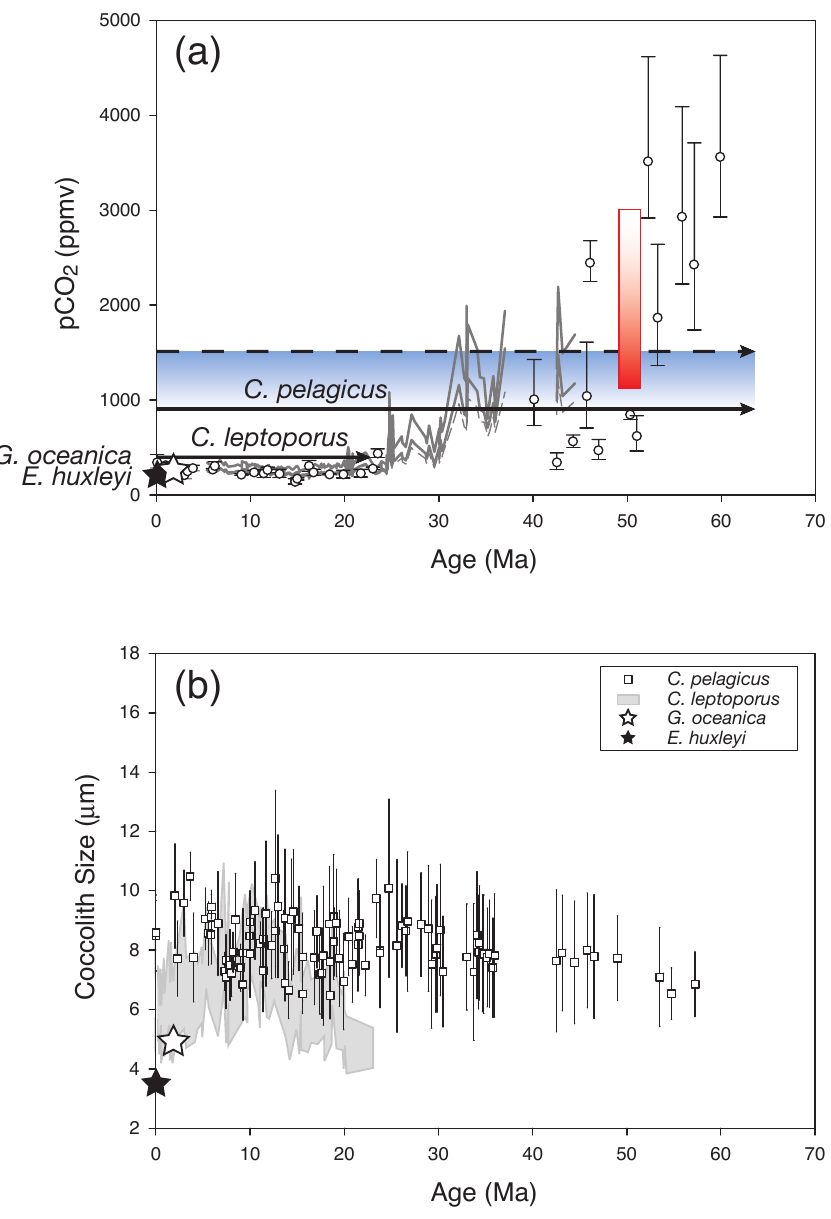
Fig. 1. (a) At face value, the levels of pCO 2 tolerated by different coccolithophore species for calcification in culture experiments (Riebesell et al., 2000; Langer et al., 2006) coincide with levels of pCO 2 from marine proxy reconstructions, based on alkenones (solid and dashed lines; Pagani et al., 2005) and boron isotopes in planktic foraminifera (open circles; Pearson and Palmer, 2000), at the time of emergence of each respective morphospecies; marked by a star for E. huxleyi (291–268ka; closed star) and G. oceanica (1.7Ma; open star), and solid arrows for C. leptoporus (23Ma) and C. pelagicus ( ∼ 63Ma). The upper pCO 2 tolerance range for C. pelagicus is indicated by the blue box with a solid arrow at the maximum pCO 2 , thus far tested, at which its calcification remains unaffected (Langer et al., 2006), and dashed arrow showing the potential for this species, with further experiments, to determine the Palaeogene maximum pCO 2 . The red box depicts the pCO 2 range in which the sodium carbonate nahcolite precipitates (Lowenstein and Demicco, 2006), fixing minimum early Eocene pCO 2 at 1125 ppmV. (b) Mean coccolith size, a proxy for coccolithophore cell size, has remained largely constant for Coccolithus during the Cenozoic decline of pCO 2 (open squares ± 1stdev; this study), and for Calcidiscus (grey envelope ± 1stdev; Knappertsbusch, 2000) since the Miocene. Both genera are significantly larger than E. huxleyi (closed star), which stands out as one of the smallest, but most prolific calcifying coccolithophore alive today and represents the youngest evolutionary addition (291–268ka) to the fossil record of calcifying